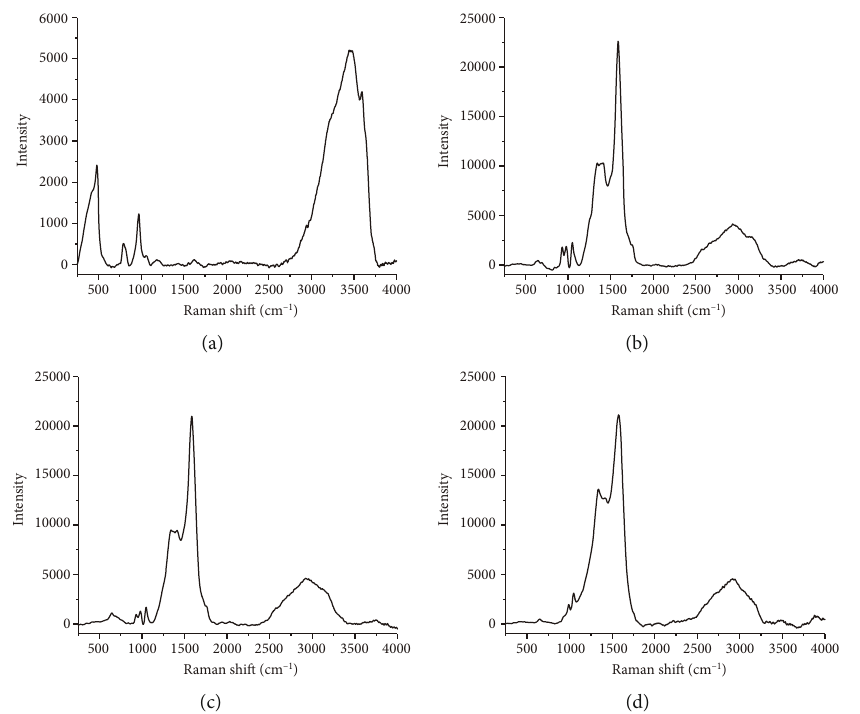
Figure 7: Raman results of (a) SiO